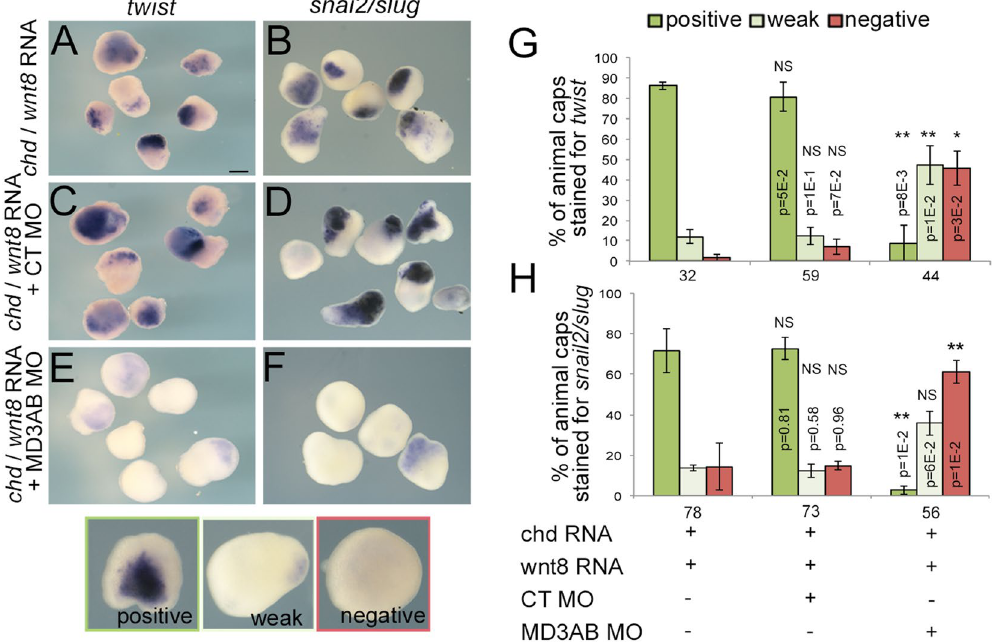
Figure 7. MarvelD3 is required for neural crest induction. Expression of the neural crest markers twist and snai2/slug during neural crest induction (stage 15) was detected by WISH in animal caps explants injected with chd mRNA + wnt8 mRNA alone ( A , B ) and co-injected with control ( C , D ) or MD3AB morpholinos ( E , F ); scale bar, 500 μ m. Neural crest induction phenotype was quantified in animal caps and classified as positive (dark green), weak (light green) and negative (red) for twist ( G ) and snai2/slug ( H ) expression. Student t-test p values and the number of animal caps analysed are